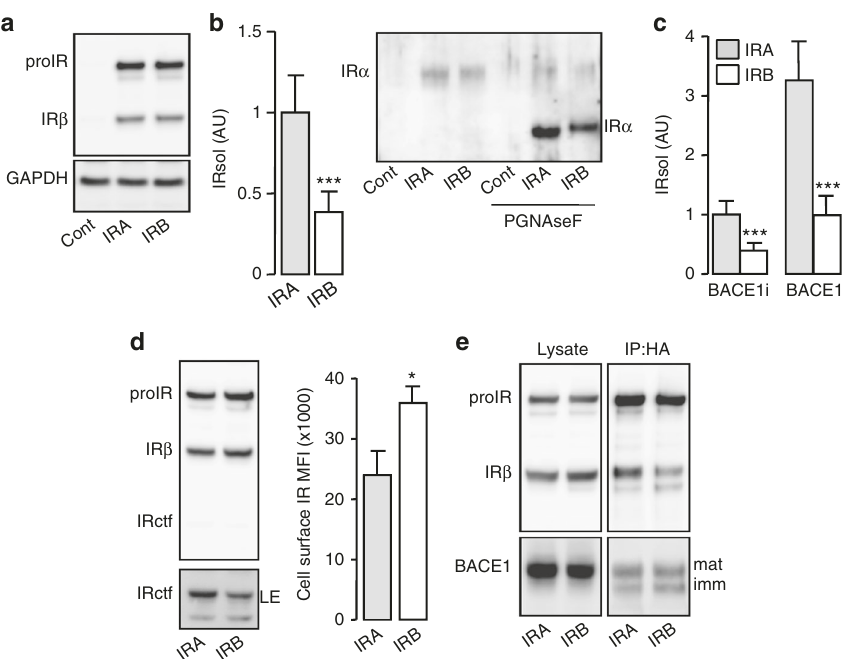
Fig. 9 BACE1-dependent cleavage of IRA and IRB. a HEK 293 cells were transfected with an empty vector (Cont) or with IRA or IRB expression vector, then IR and endogenous GAPDH expression were detected by immunoblot. b IRsol was measured in conditioned media of cell expressing IRA or IRB by ELISA (left) and by immunobloting of the conditioned media untreated or treated with PGNaseF. c Cells were transfected with the indicated combinations of IRA, IRB and BACE1, and inactive BACE1 (BACE1i) expression vectors; then IRsol was measured by ELISA in conditioned media. d BACE1 overexpressing cells were transfected with IRA or IRB expression vector and IR was detected by immunoblot (left) or at the cell surface by fl ow cytometry (right). LE indicates a long exposure of the immunoblot. e Inactive BACE1 was co-immunoprecipitated with IRA or IRB as described in Fig. 2g. Immature (imm) and mature (mat) BACE1 are indicated. Data are means ± s.d. Statistical analyses were made using unpaired t -test. * p < 0.05; *** p <